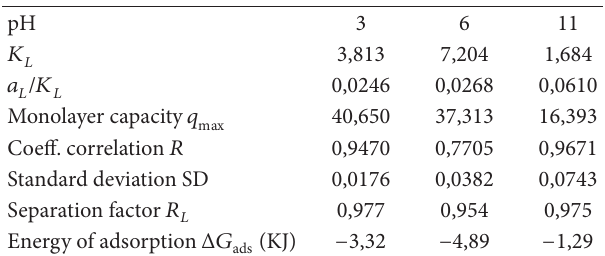
F 3: SEM of cellulosic �bers graed/cd-nma.